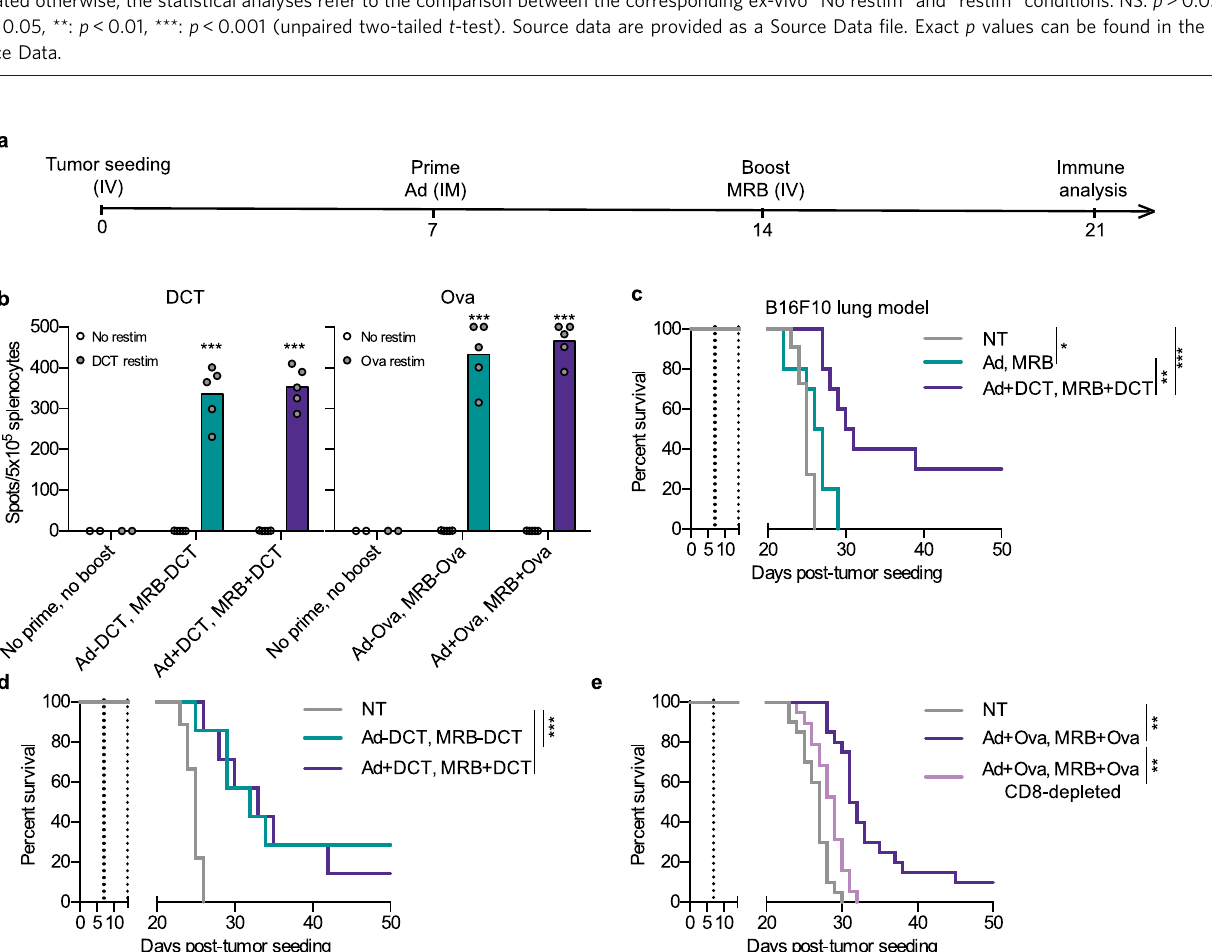
Fig. 4 OVs can function as both priming and boosting adjuvants in heterologous vaccination regimens. a Treatment schedule used in this study. b IFN γ ELISPOT analysis of splenocytes from mice primed with Ad-DCT on day 7 and boosted with MRB-DCT on day 14 or primed and boosted with Ad and MRB co-administered with DCT peptide (left graph); or primed with Ad-Ova on day 7 and boosted with MRB-Ova on day 14 or primed and boosted with Ad and MRB co-administered with Ova peptide (right graph) (from left to right; n = 2, 5 and 5). The statistical analyses refer to the comparison between the corresponding ex-vivo “ No restim ” and “ restim ” conditions. NS: p > 0.05, ***: p < 0.001 (unpaired two-tailed t -test). Kaplan – Meier survival analyses of B16F10 lung tumor-bearing mice treated with; c Ad (day 7) and MRB (day 14) or Ad and MRB co-administered with DCT peptide ( n = 10 (Ad, MRB and Ad + DCT, MRB + DCT) and 11 (NT)); d Ad-DCT on day 7 and MRB-DCT or MRB co-administered with DCT peptide on day 14 or ( n = 7 (Ad-DCT, MRB- DCT and Ad + DCT, MRB + DCT) and 9 (NT)); e Ad-Ova on day 7 and MRB co-administered with Ova peptide on day 14 with or without CD8 depletion ( n = 20 (NT and Ad + Ova, MRB + Ova) and 19 (Ad + Ova, MRB + Ova -CD8), 2 experiments combined). p > 0.05, *: p < 0.05, **: p < 0.01, ***: p < 0.001 (Mantel – Cox test, two-sided). Source data are provided as a Source Data fi le. Exact p values can be found in the Source